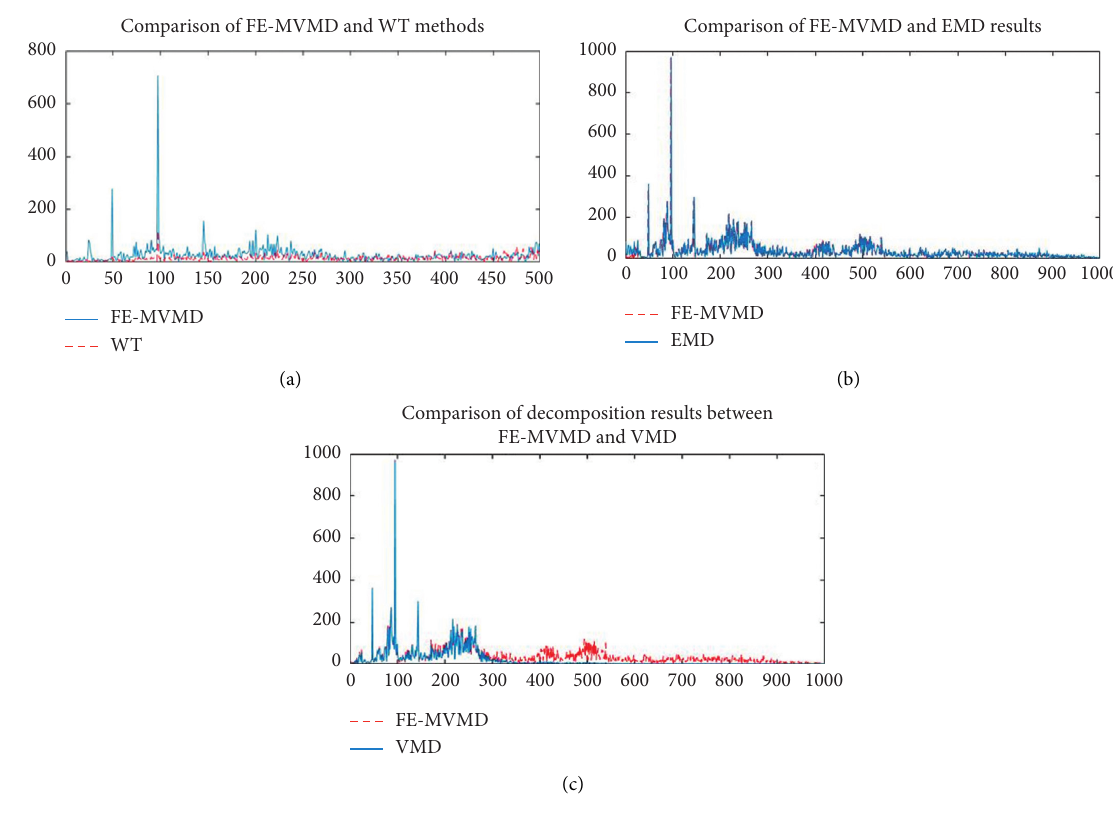
Figure 6: Comparison of modal component extraction results. Table 1: XGBoost modal result classification.